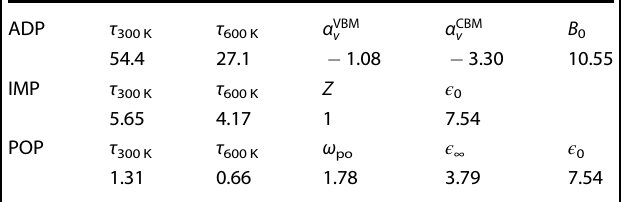
& α CBM are the v v